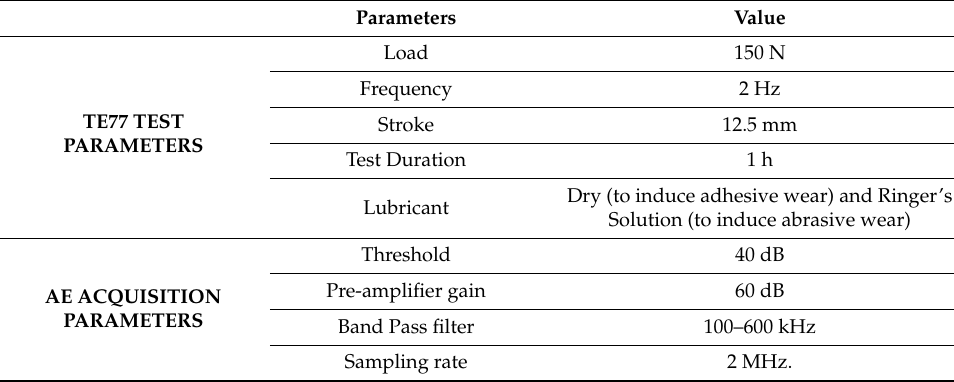
Table 1. TE77 and AE acquisition